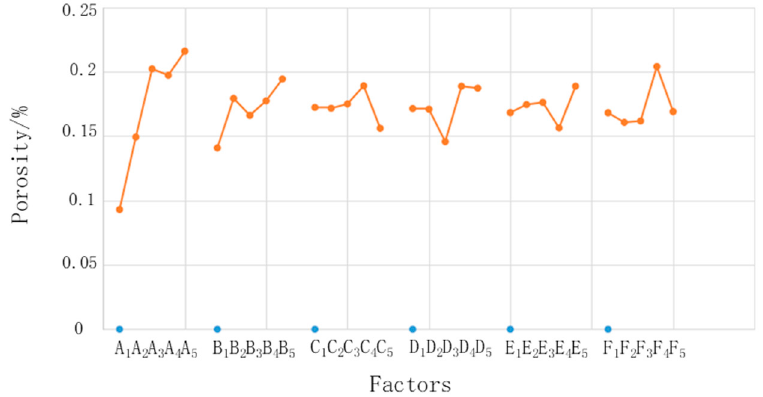
Figure 6. Relationships between the factors and porosity.